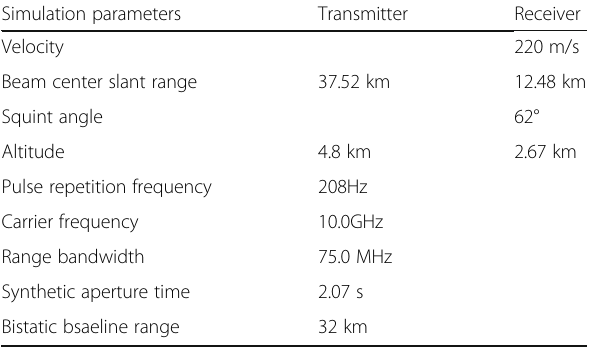
Table 1 Stationary parameters of BiSAR Simulation parameters